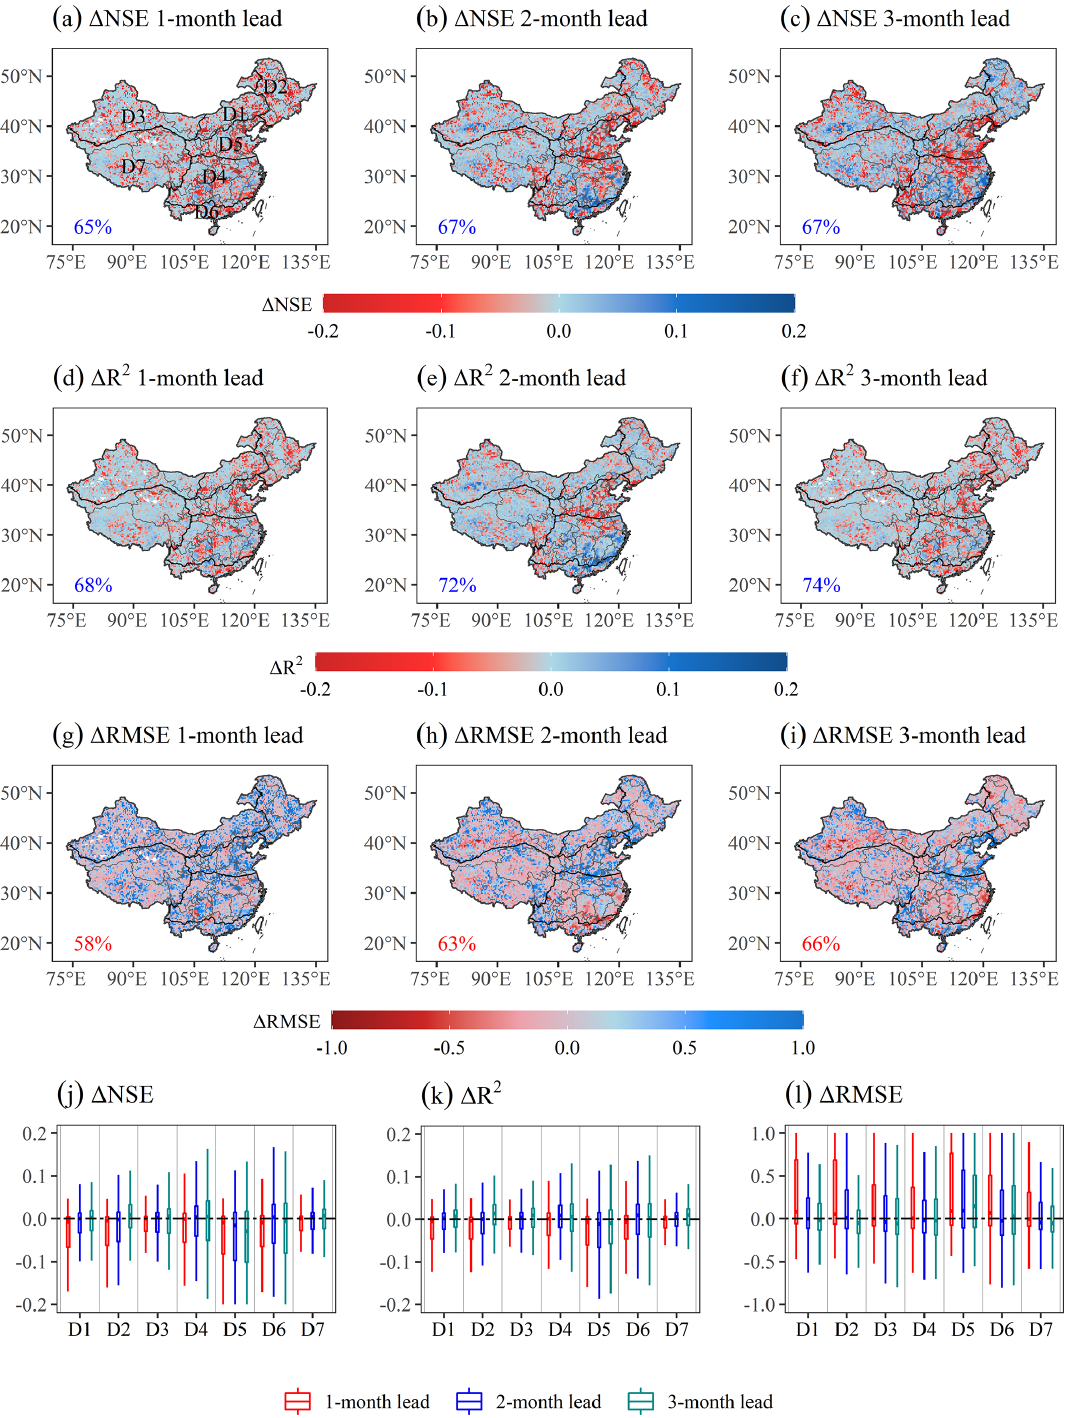
Figure 5. Forecast performance based on (a) – (c) (cid:49) NSE (the difference in NSE between the 3C-vine and MG models, NSE 3C − NSE MG ), − R 2 (d–f) (cid:49)R 2 ( R 2 ), and (g–i) (cid:49) RMSE (RMSE 3C − RMSE MG ) for the 1- to 3-month lead times in August during 1961–2018 over 3C MG China. The corresponding box plots of (j) (cid:49) NSE, (k) (cid:49)R 2 , and (l) (cid:49) RMSE relative to a threshold of zero (horizontal black dash line) for agricultural drought forecast in August for 1- and 3-month lead times in climate regions D1–D7 over China are also shown. The percentages of (cid:49) NSE > 0, (cid:49)R 2 > 0, and (cid:49) RMSE < 0 are listed in the bottom left of the corresponding subfigures.